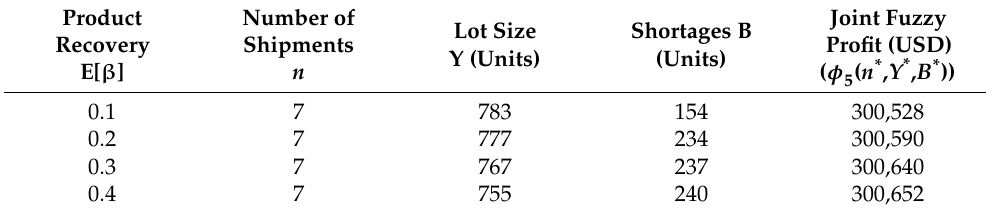
Table 7. Impacts of the product recovery parameters on the decision variables and joint fuzzy profit.